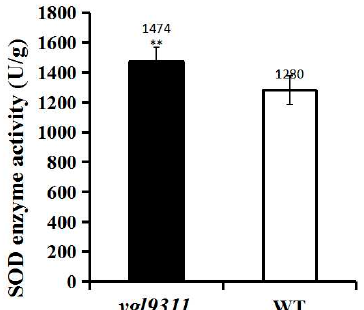
Figure 2. Comparison of major agronomic traits between mutant ygl9311 and the wild-type parent 9311. Bars represent standard deviations of ten independent measurements. Significant differences were determined by Duncan ′ s Multiple Range test.